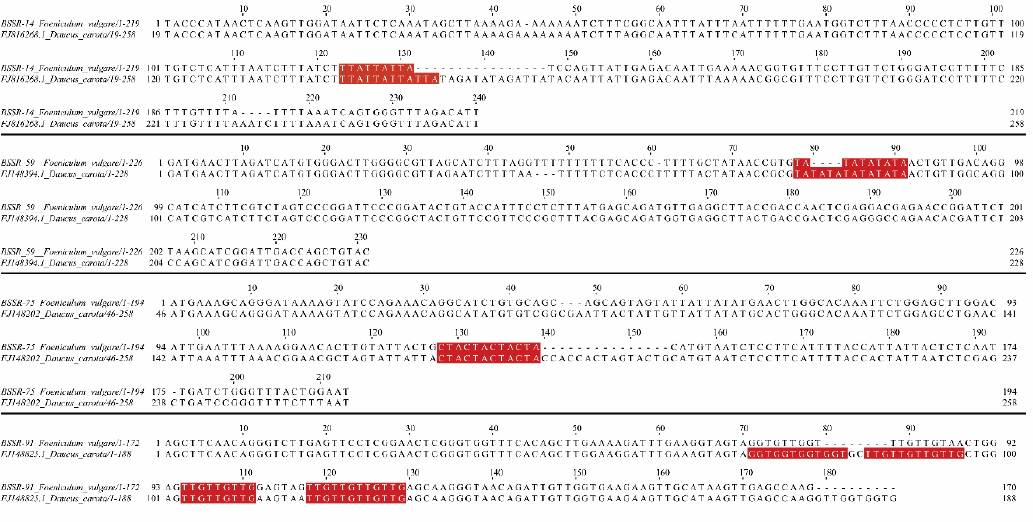
Figure 1. Sequence alignments between simple sequence repeat (SSR) flanking regions of carrot (from Cavagnaro et al. [43]) and fennel. Common SSR motifs are highlighted in red.